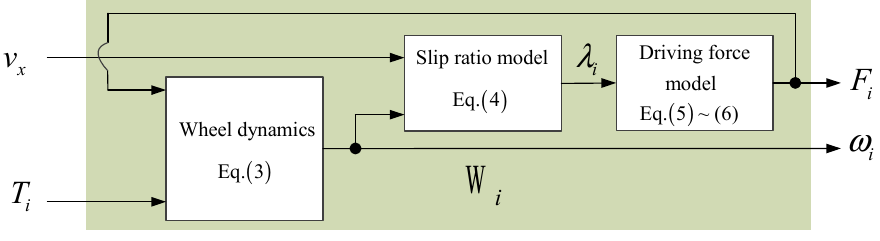
( b ) Case B (Locally stable & Globally unstable) Figure 5. Motivating example: anti-slip control by wheel velocity control. Case A: Two stable poles of P cl (s) are placed at κ = −